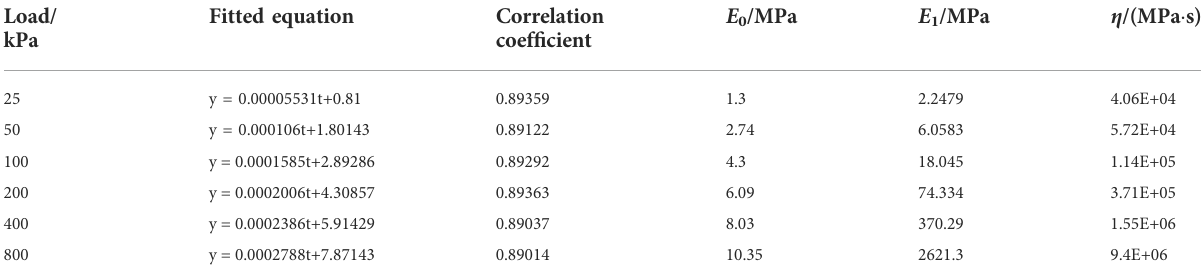
TABLE 4 Rheological model fi tting results and parameters of the samples when the ratio of bio-enzyme was 0.02%. Load/ kPa